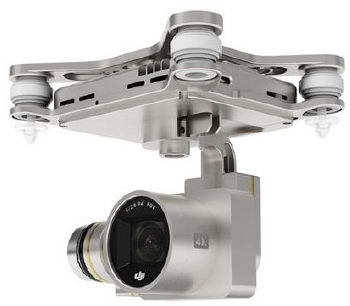
Figure 12. “Sony EXMOR 1/2.3”— 4 K” camera mounted on phantom 3 professional.